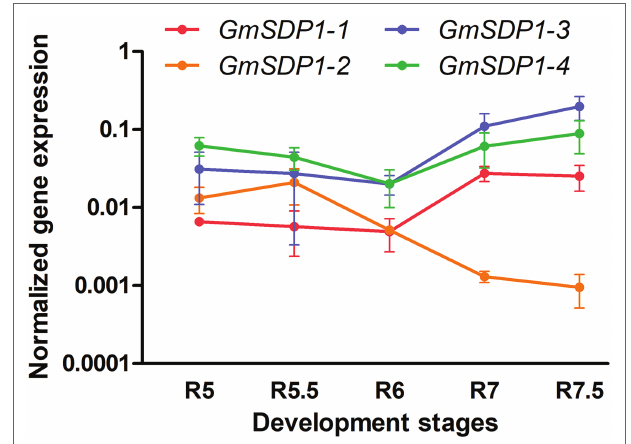
FIGURE 2 | Expression of soybean SDP1 genes during seed development. GmSDP1 transcript levels were quantified using RT-qPCR with paralog- specific primers and normalized to the geometric mean of the expression of soybean ATP and SKIP16 genes. Values represent the mean ± SD of normalized expression levels of seeds collected from three individual